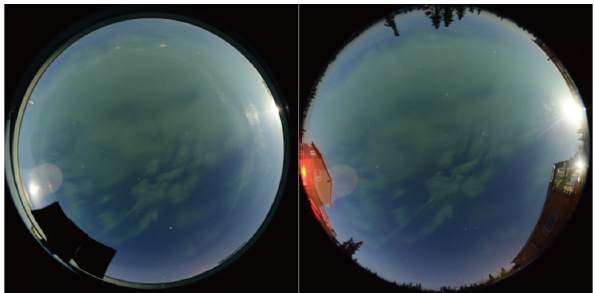
Fig. 2. All-sky images of patchy structure of pulsating aurora as obtained from (left) PFRR and from (right) ABL at 16:25UT on 26 January 2013. Camera settings are ISO3200 and 5s exposure time. The format is the same as Fig. 1.